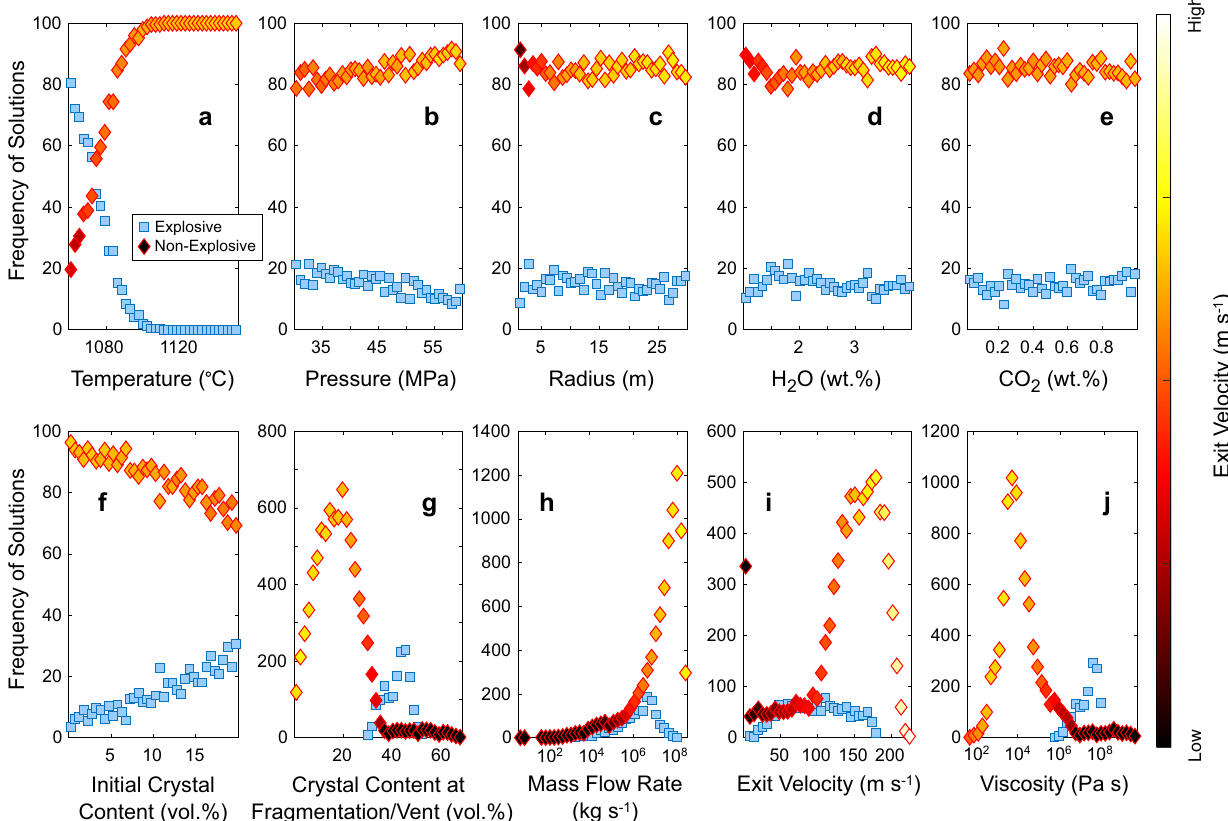
Content (vol.%) Fig. 9 Results of the sensitivity analysis. Explosive solutions are shown in blue. Non-explosive solutions are coloured according to average exit velocity, according to the colour bar. The frequency of solutions is plotted against the input parameters ( a ) initial temperature, ( b ) initial pressure, ( c ) conduit radius, ( d ) initial H 2 O concentration, ( e ) initial CO 2 concentration, and ( f ) initial crystal content. Results are plotted as the number of solutions, but for the input parameters ( a – f ) the sum of the frequencies is 100, and therefore these results are expressed as a percentage. Also presented are the frequency of solutions plotted against output parameters ( g ) crystal content at fragmentation (for explosive solutions) and at the vent (for non-explosive solutions) ( h ) mass fl ow rate, ( i ) exit velocity, and ( j ) viscosity, at fragmentation for the explosive case, and at the vent for the non-explosive case. For the output parameters ( g – j ) the sum is variable and expressed as the raw